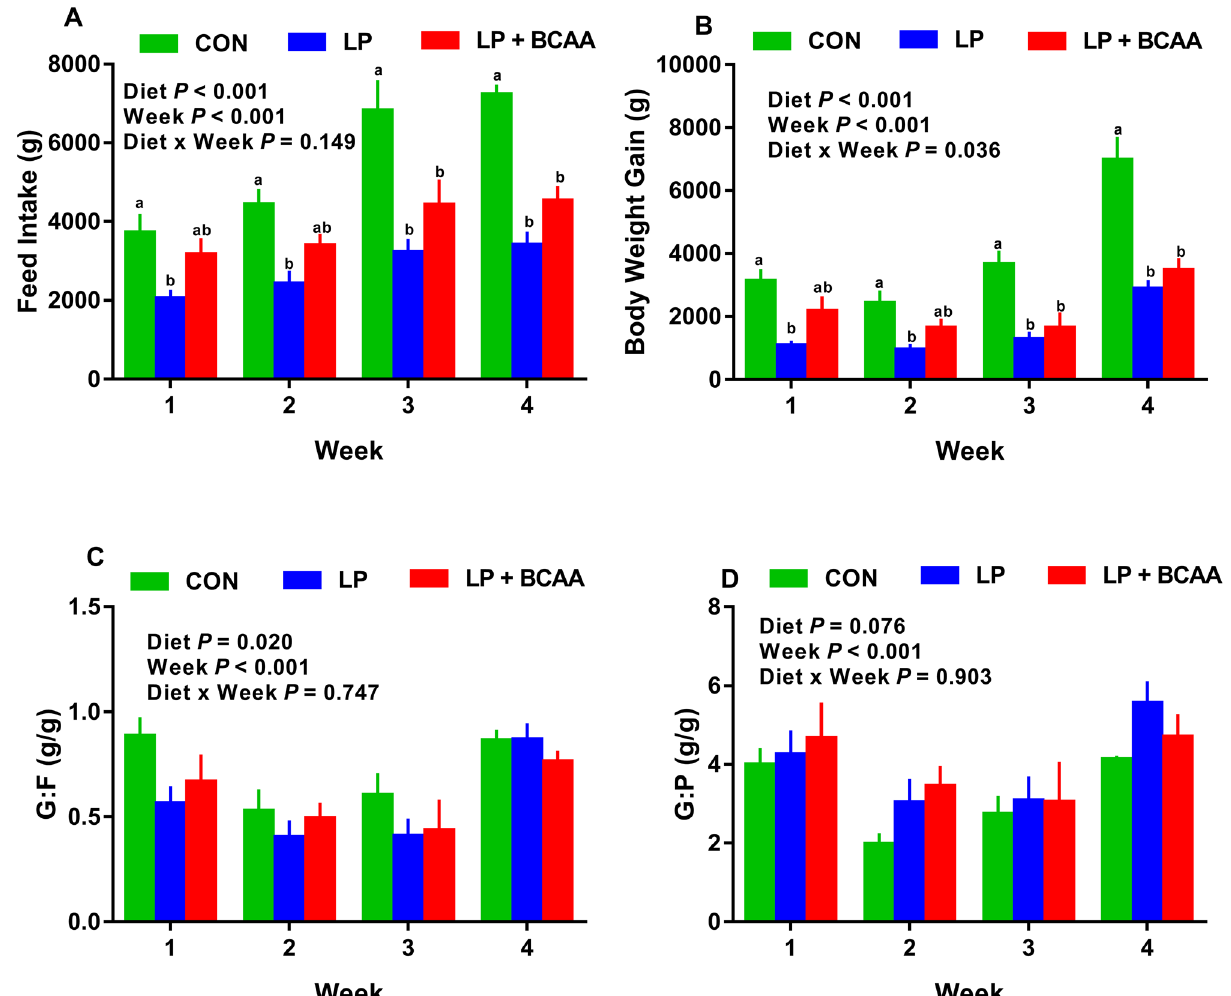
Figure 2. Effect of very low protein diets supplemented with branched-chain amino acids on weekly feed intake, body weight gain and feed and protein efficiency ratio. ( A ) cumulative feed intake, ( B ) body weight gain, ( C ) gain to feed ratio (G:F), and ( D ) gain to protein ratio (G:P). CON, control diet; LP, low protein diet; LP + BCAA, low protein diet supplemented with branched-chain amino acids. Among groups, values with different superscripts are different ( P ≤ 0.05). The values are means ± standard errors of means, n =